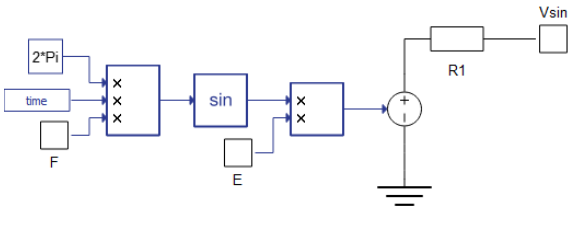
Figure 20. Converter experiment